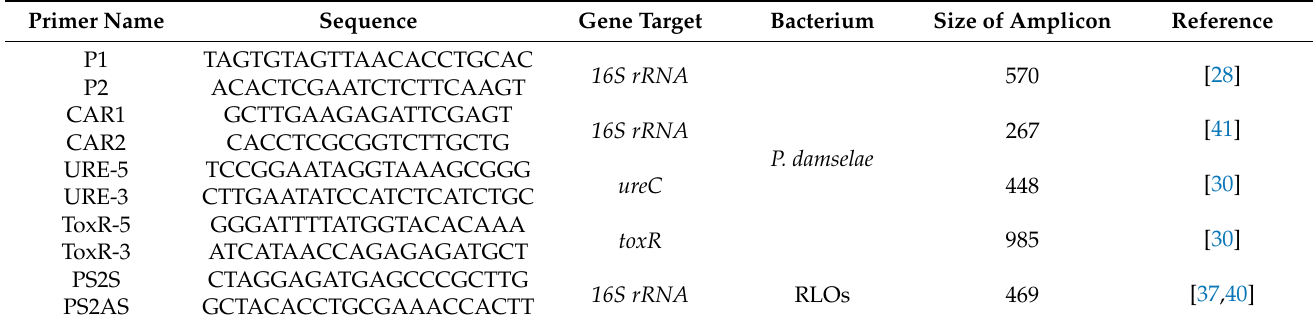
Table 2. Primers used to screen for P. damselae , RLOs and identify P. damselae subspecies out of P. damselae -positive PCR